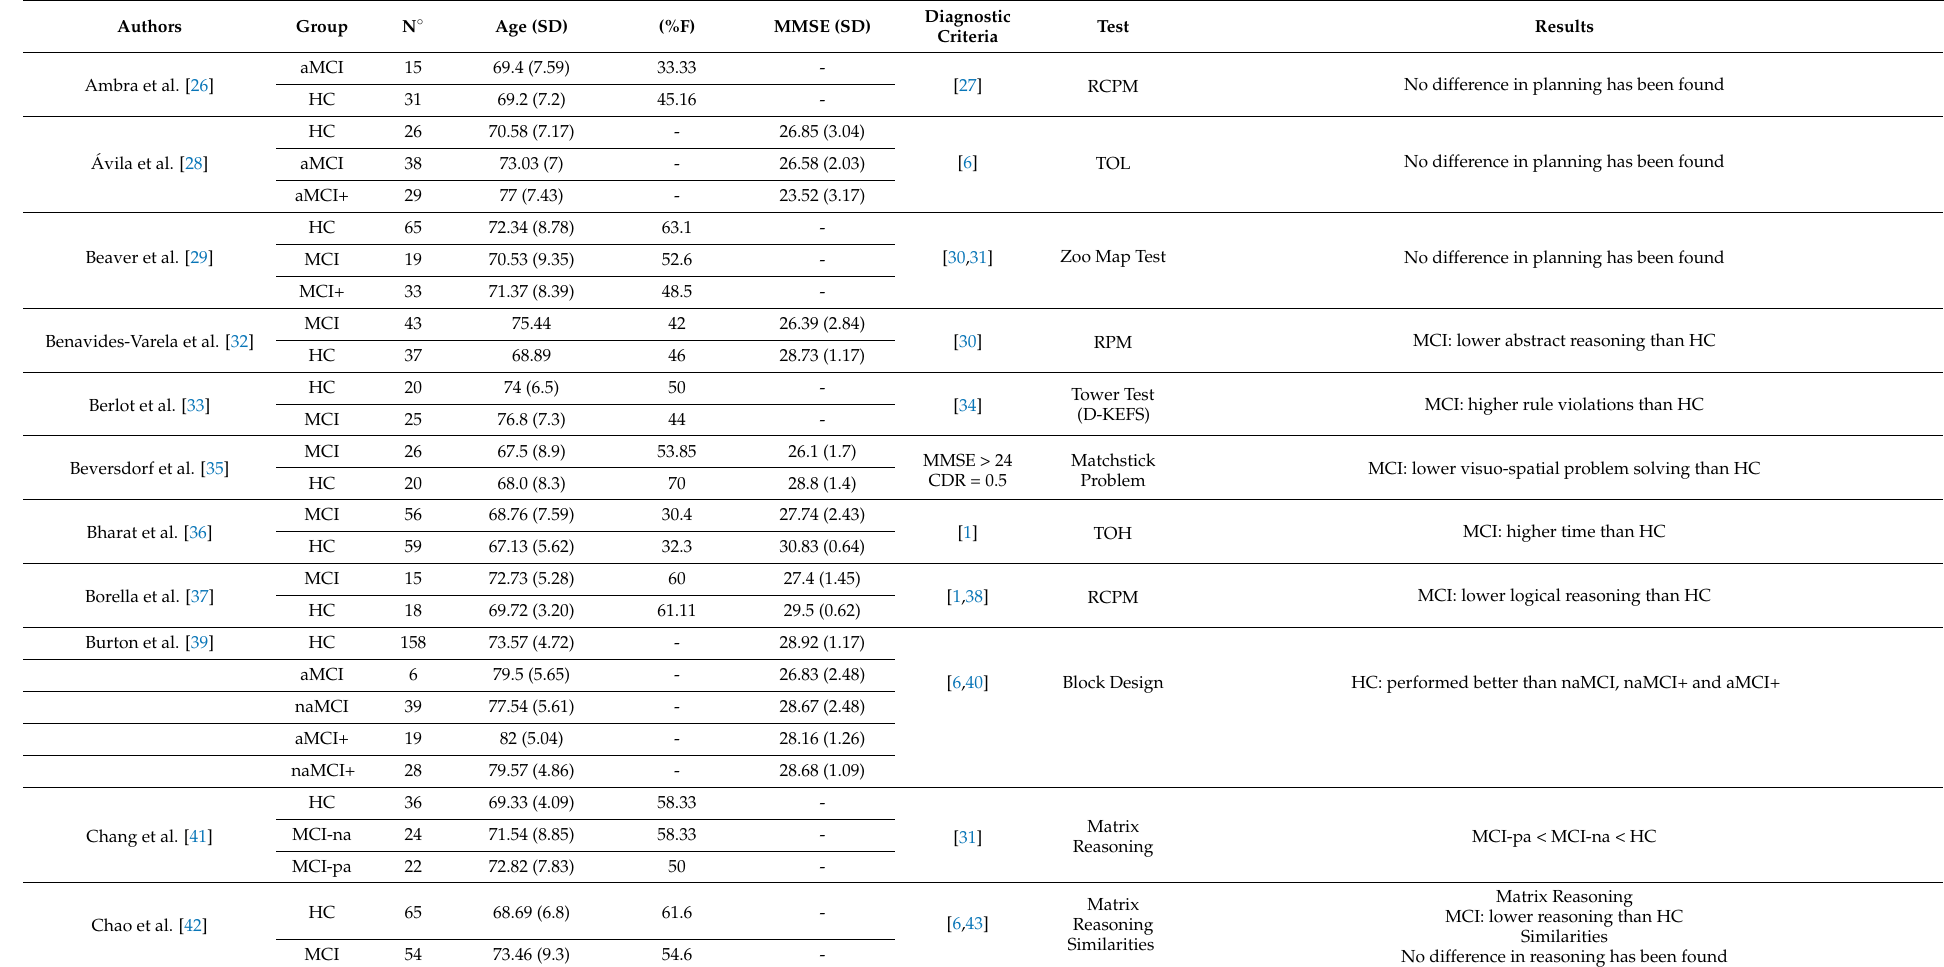
Table 2. Results of selected